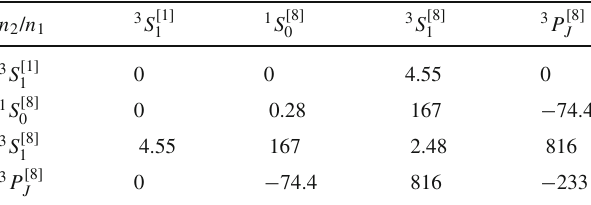
Table 2 The values of ˆ σ n in ( fb / GeV 6 ) up to order O (α 2 α 3 s ) . The 1 + n 2 convention introduced in Eq. (19) is adopted labeltab